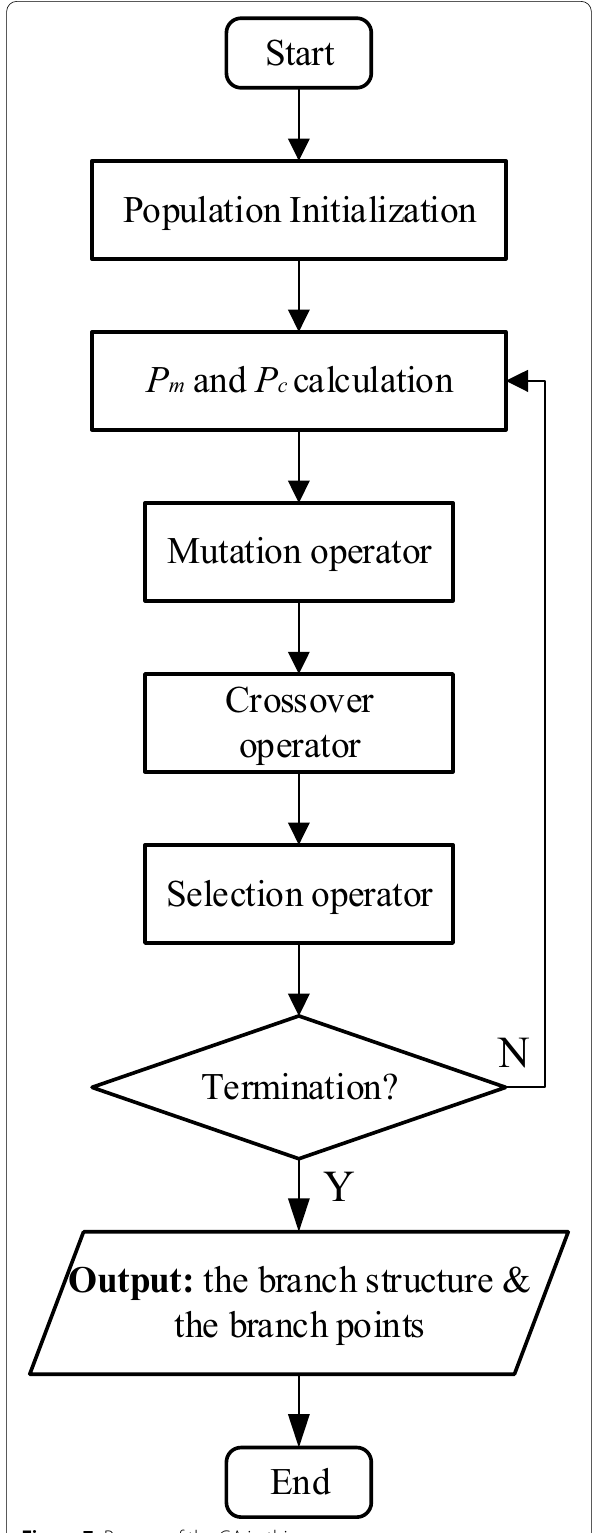
Figure 7 Process of the GA in this paper